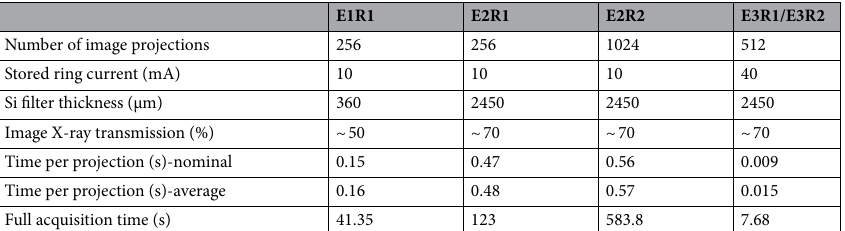
Table 1. XCT data collection parameters used for different experiments (E) and imaged roots (R). †